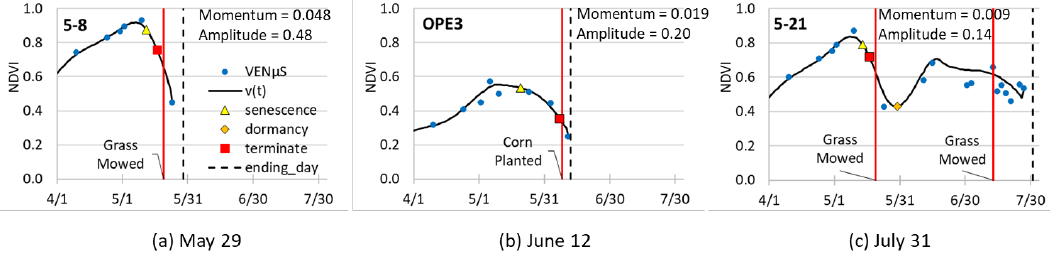
Figure 12. Three examples from the near-real-time simulation from field #5-8 on 29 May ( a ), the OPE3 site on 12 June ( b ), and field #5-21 on 31 July ( c ), for explaining the weekly results in Figure 11e,g,n, respectively. Vertical red lines show the recorded harvest dates.